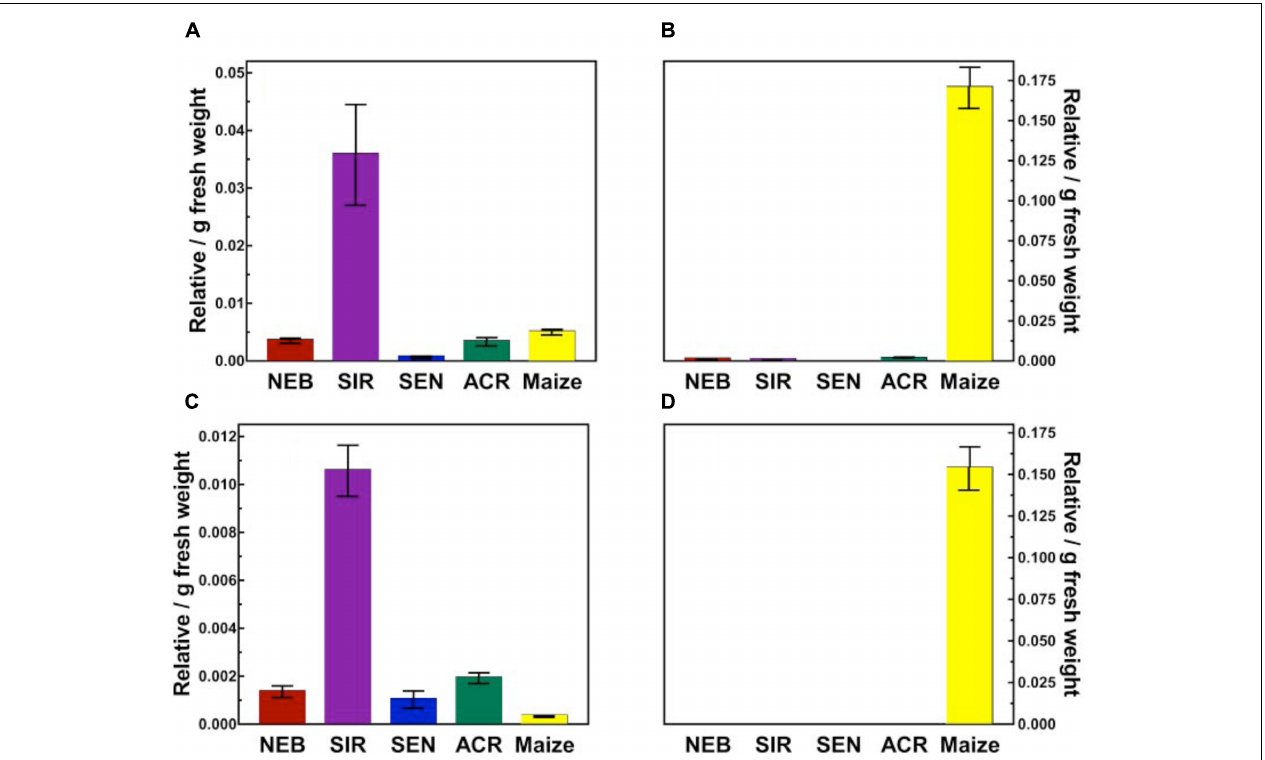
FIGURE 4 | Quantification of topramezone metabolites in treated leaves from four waterhemp populations and maize 48 HAT using whole plants. The third- and fourth-youngest leaves from waterhemp and maize plants (10–12 cm tall) were treated with 60 × 0.33 µ L droplets (20 µ L total) of a 1.5 mM topramezone solution, including 0.1% (v/v) Tween 20 as a leaf wetting agent, using a glass syringe. Only the treated leaves were harvested from each plant at 24 and 48 HAT (only 48 HAT data are shown), extracted and partially purified by SPE chromatography, then analyzed by LC-MS (low resolution) as described in Section “Materials and Methods.” Relative concentrations of each topramezone metabolite extracted from the treated leaves are plotted on the Y -axis (authentic standards were not available), using pyrasulfotole as an internal standard as described in Section “Materials and Methods.” (A) Putative hydroxytopramezone-1. (B) Desmethyl-topramezone. (C) Putative hydroxytopramezone-2. (D) Putative benzoic acid metabolite of topramezone (only detected in maize). Vertical bars represent the standard error of the treatment